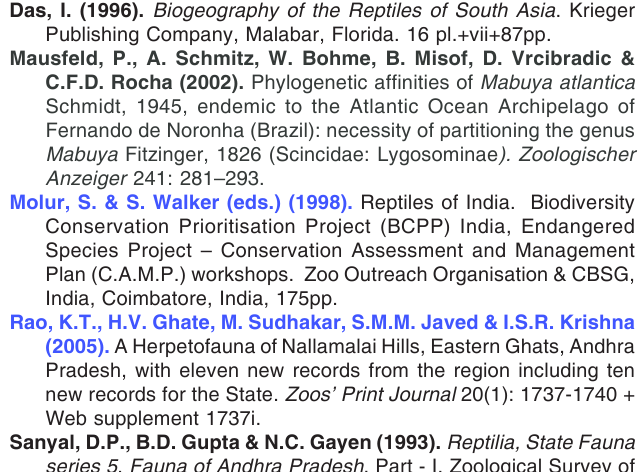
Images 7-8. Eutropis innotata. 7 - Lateral aspect of head showing eye with undivided transparent disc in lower eye lid, loreals (L1 & L2), nasal (N) and no postnasal; 8 - Lateral aspect of eye close up showing undivided transparent disc (TD) in lower eye lid. (2002). The distinguishing characters and key to the known species (from peninsular India) of the genus Eutropis having lower eyelid with undivided, more or less, transparent disc is as given below: 28 to 30 scales round the mid-body; dorsals with 5 to 7 keels 34 to 38 scales round the mid body: dorsals with 2 or 3 strong 32 to 34 scales round the mid body; dorsals feebly 32 to 34 scales round the mid body; dorsals with 7 to 11 keels